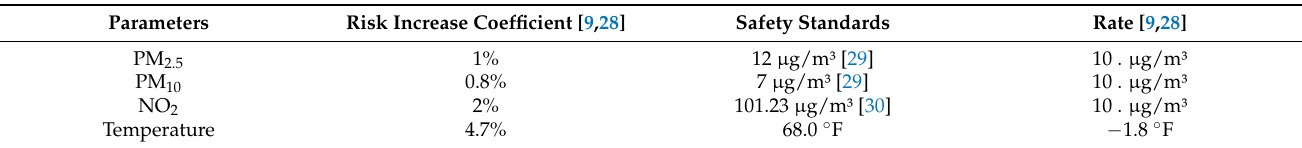
Table 2. Correlations between the degradation of the environmental and meteorological factors and the increase in COPD exacerbation risks, derived from retrospective medical studies [9,28]. As an example, these studies demonstrated that an increase in NO 2 concentration by 10 ug/m³ resulted in about 2% increase in the risk. These correlations were used to estimate the overall risk trends based on the real-time data from local